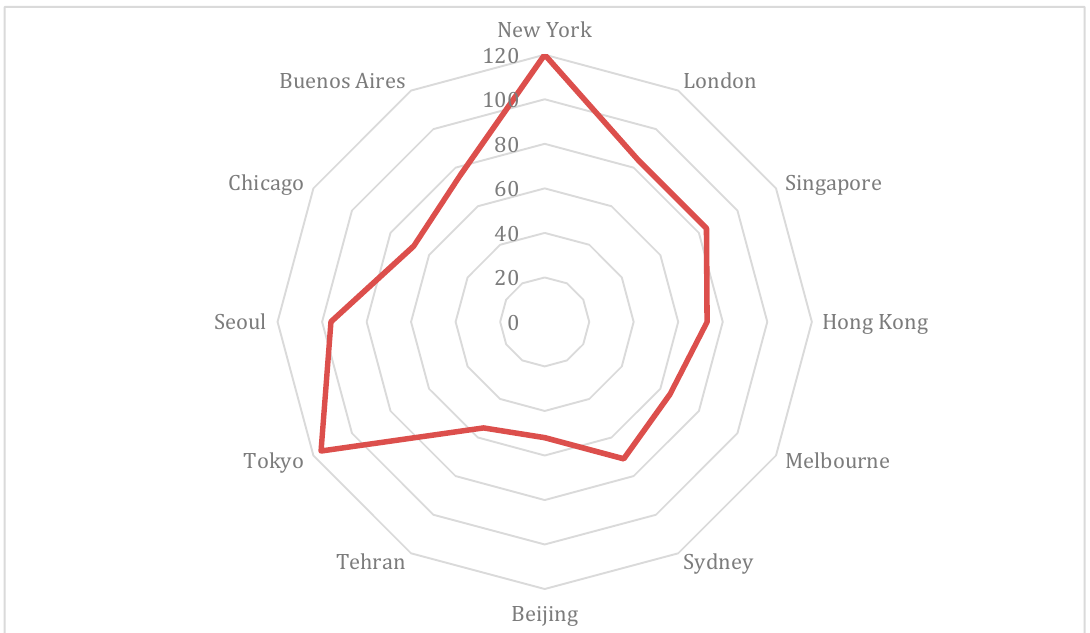
Figure 1. Average commuting time in big cities around the world.